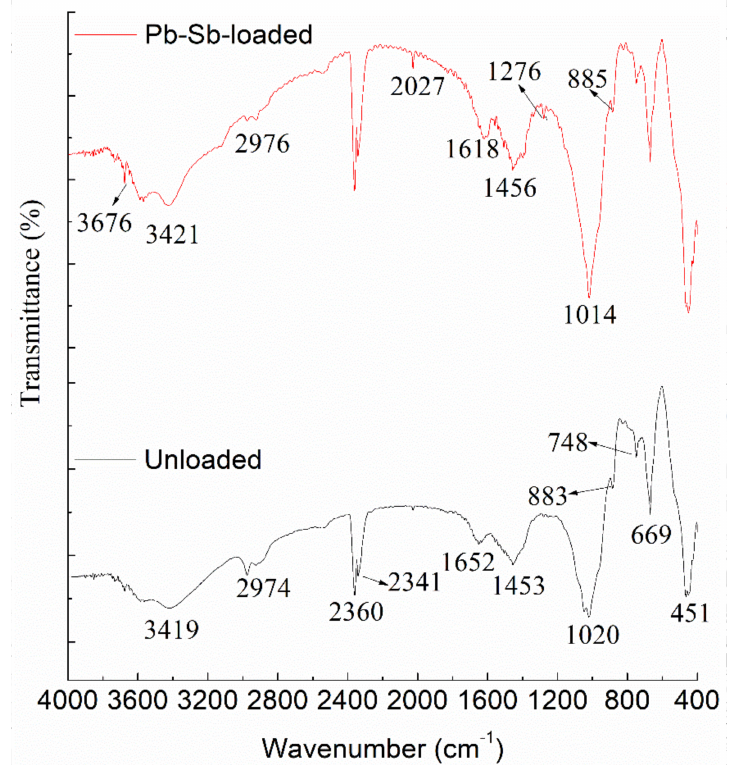
Figure 2. FT-IR spectrum of dried unloaded biomass and Pb-Sb-loaded biomass. Table 1. Assignment of FT-IR spectroscopy of dried unloaded and Pb-Sb-loaded B. subtilis biomass. Wavelength (cm − 1